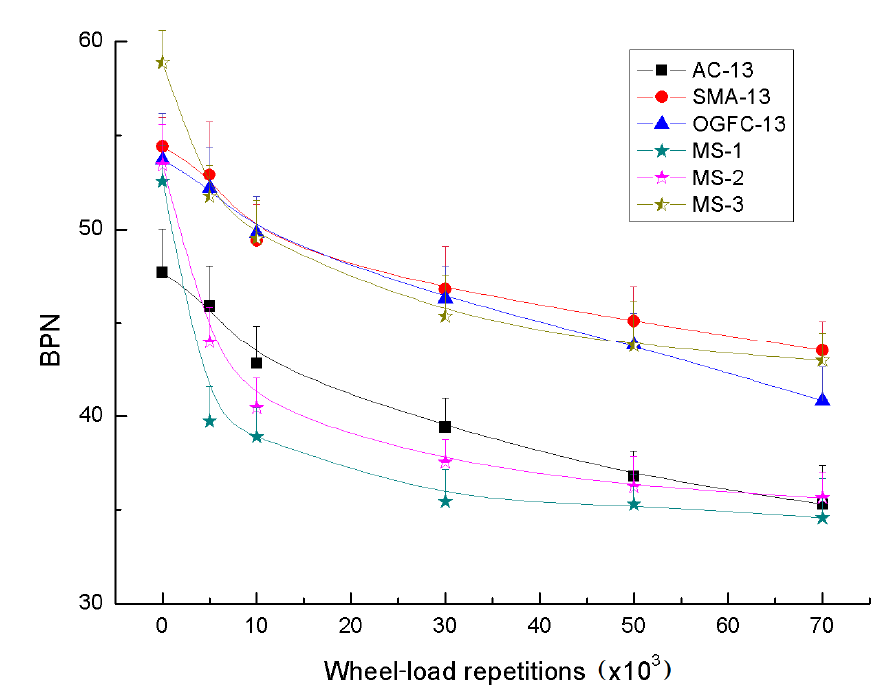
Figure 11. BPN of the mixture under different wheel-load repetitions.